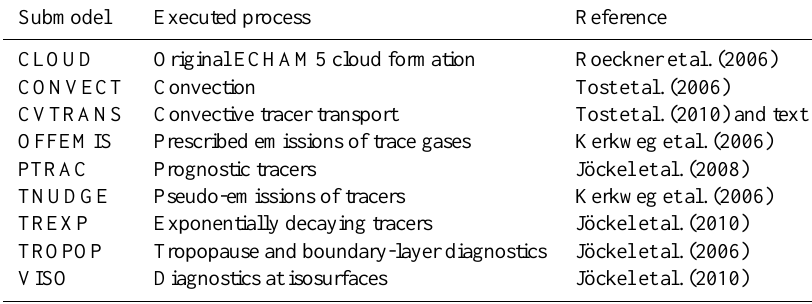
Table 1. Optional MESSy submodels that are enabled for the numerical experiments.